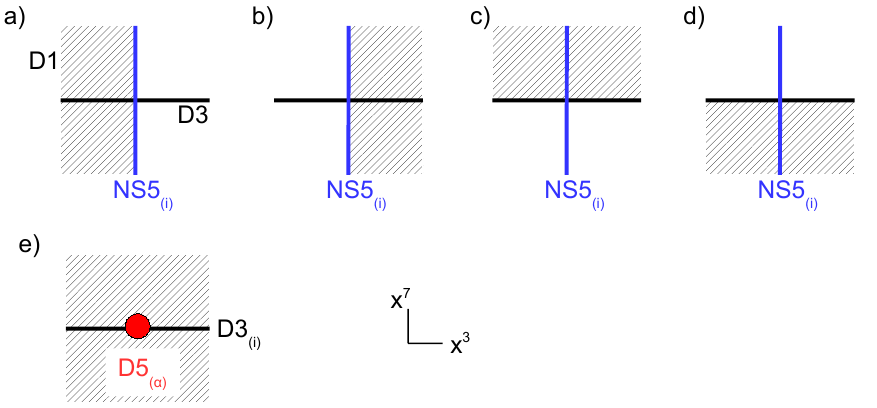
segment, inserting ’ i . ( i )